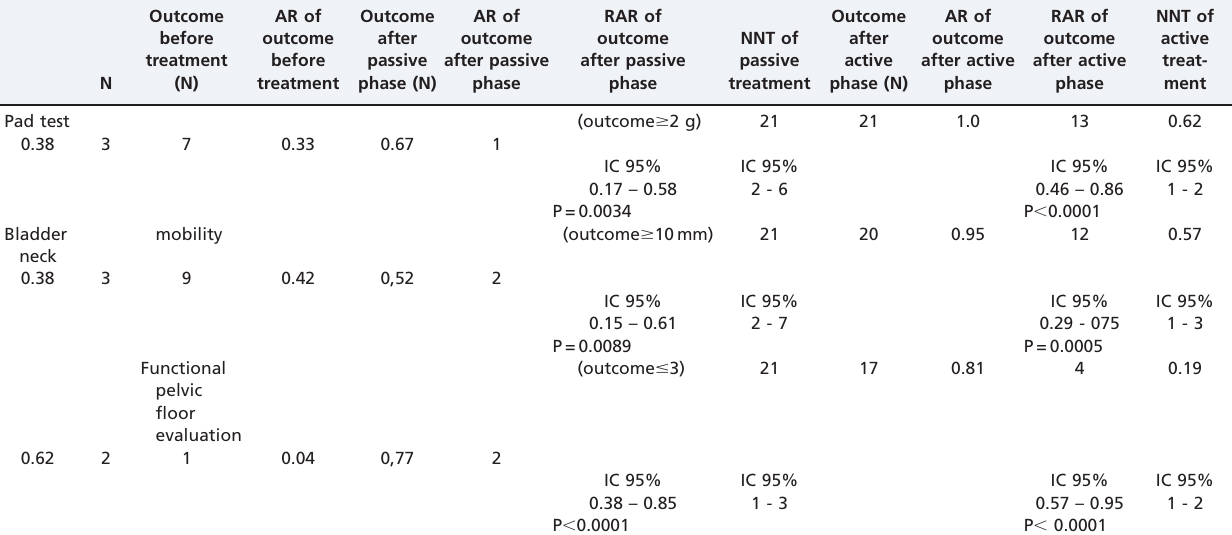
Table 1 - Analysis of the pad test, the bladder neck mobility, and the functional pelvic floor evaluation at baseline and at the end of the passive and active phases.